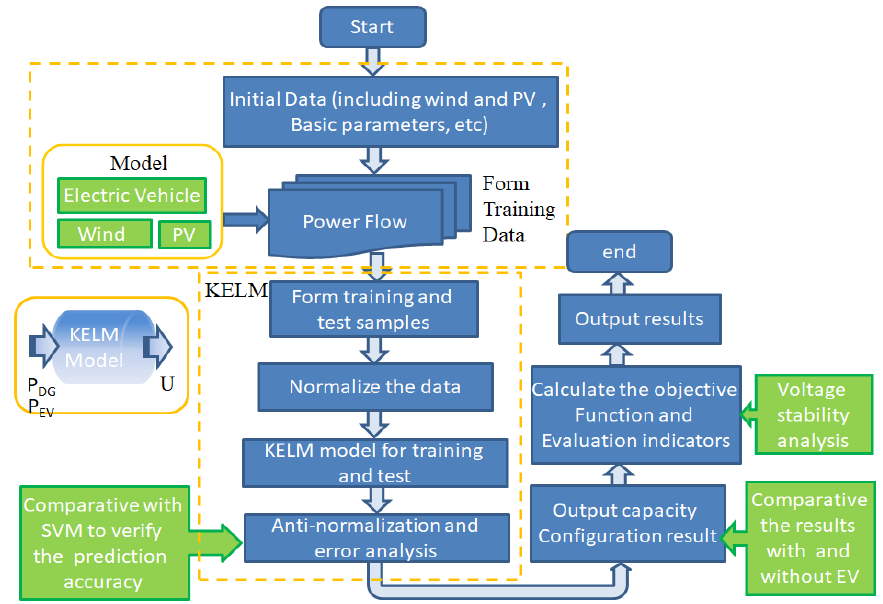
Figure 2. Flowchart of KELM algorithm. (PV: Photovoltaic; EV: Electric Vehicle; SVM: Support vector machine)